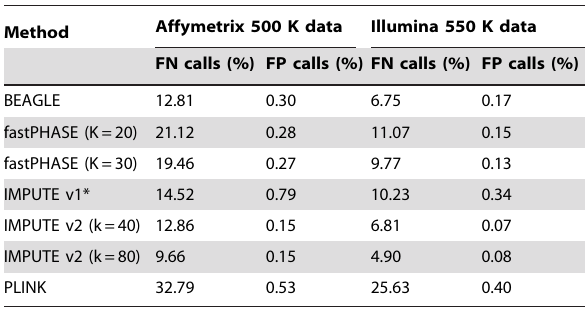
Table 2. False negative (FN) and false positive (FP) minor allele call rates at rare SNPs (MAF , 5%) in Scenario